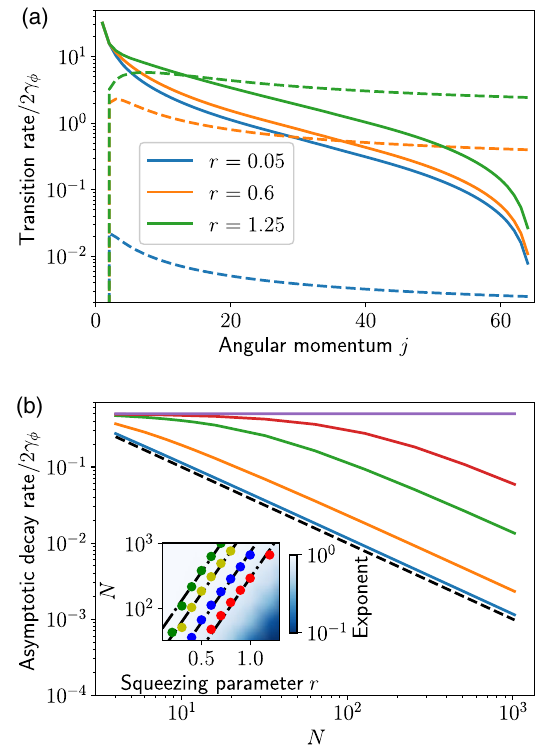
FIG. 14. (a) Transition rates j − 1 → j (solid) and j → j − 1 (dashed) between different angular-momentum subspaces due to local dephasing for N ¼ 128 and Γ ¼ 1 . (b) Asymptotic decay rate in the presence of local dephasing for r ¼ 0 . 2 , 0.5, 1.0, 1.4, and 4.0 (bottom to top). The dashed black line indicates 1 =N scaling obtained for r ¼ 0 . Inset: scaling exponent a in 1 =N a as a function of N and r . The data points indicate the positions where a becomes smaller than 0.99, 0.98, 0.95, and 0.9 (left to right). The dash-dotted black lines are a guide to the eye and indicate e 5 r